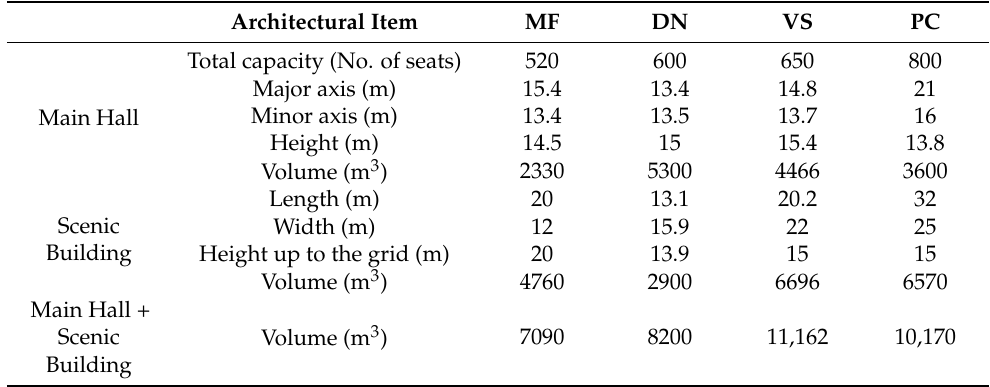
Figure 12. Spatial distribution of C 80 ( a ) and D 50 ( b ) simulated at 50% and 100% occupancy.